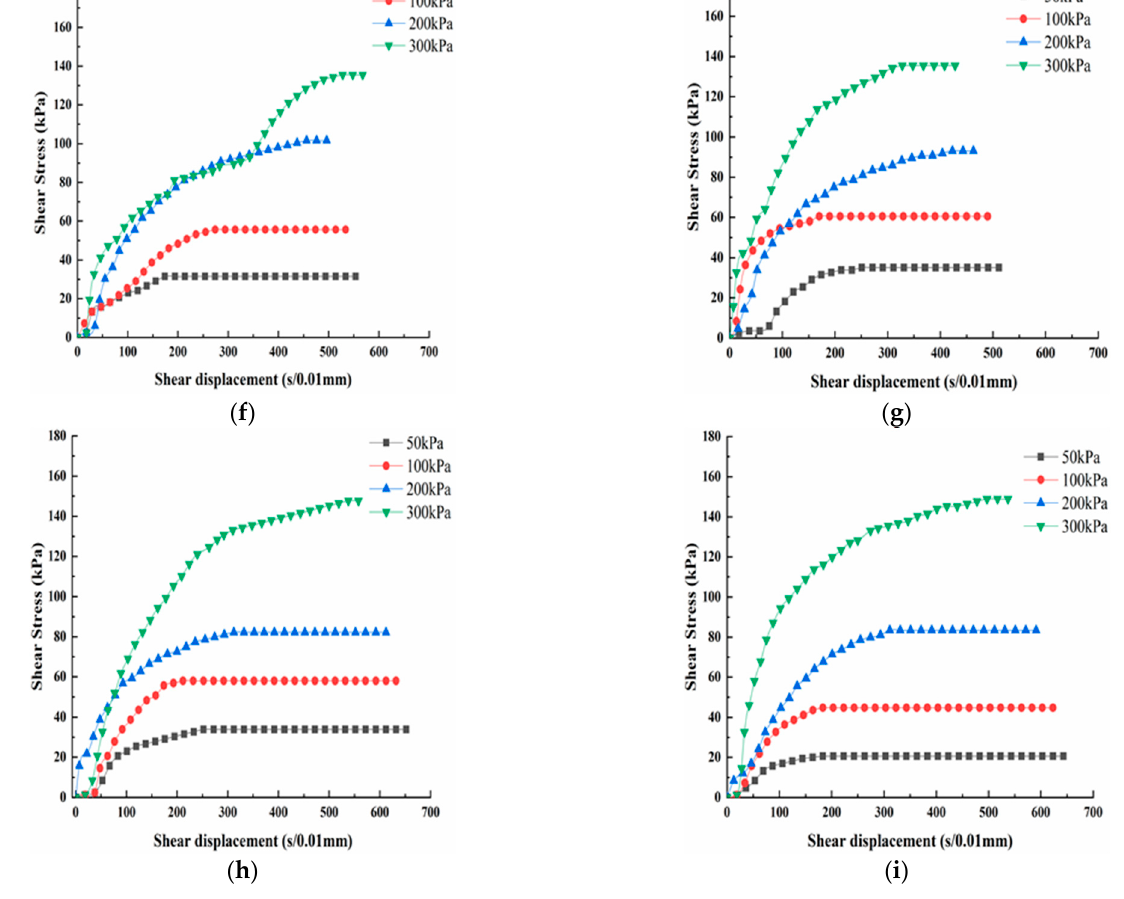
Figure 6. The stress-displacement curves of the modified loess. ( a ) Z0; ( b ) Z1; ( c ) Z2; ( d ) Z3; ( e ) Z4; ( f ) Z5; ( g ) Z6; ( h ) Z7; and ( i ) Z8.